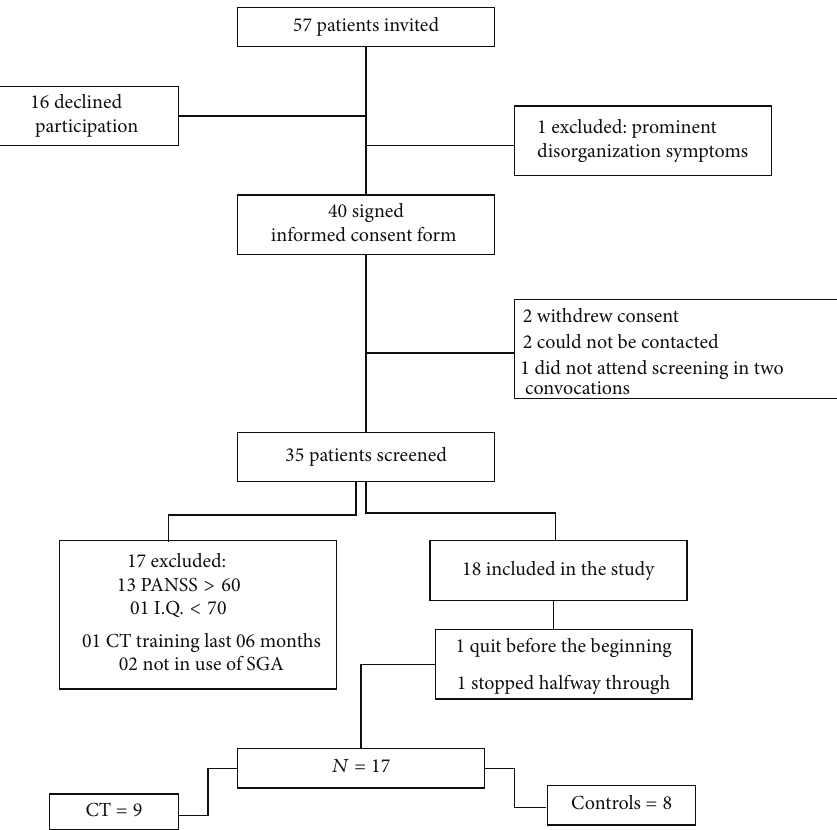
Figure 1: Consort diagram. CT indicates cognitive training; SGA indicates second generation